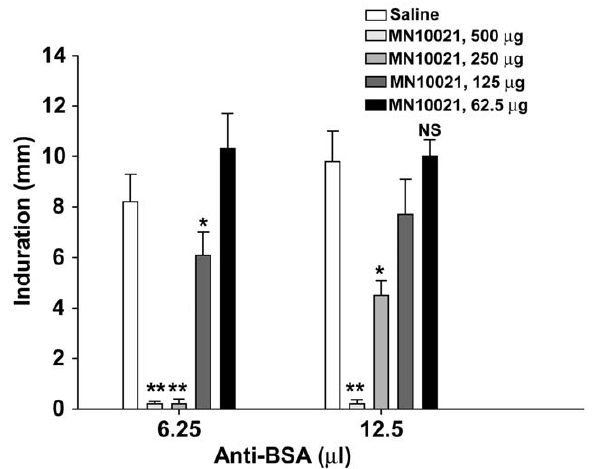
Figure 5. MN10021 inhibits dermal vascular leak in a reverse passive Arthus reaction. Groups of 5 Hartley strain guinea pigs (male; , 250 g) were injected s.c. with 1.0 ml of either saline or the indicated dose of MN10021. Eighteen hours later the flanks of the animals were shaved and both 6.25 and 12.5 m l of rabbit anti-BSA antiserum injected i.d. at each of two sites, one on each flank. The animals were then injected i.v. with 1.0 ml of PBS containing BSA (1.0 mg/ml) and Evans Blue dye (2.0 mg/ml). Six hours later the animals were euthanized by barbiturate overdose, the skin on the back removed, and the diameter of the extravasation of the Evans Blue dye measured for each site on the ventral surface of the skin. The values represent the mean 6 SE of the 10 measurements obtained for each of the treatment conditions. ** p , 0.01; * p , 0.05; NS = not significant.